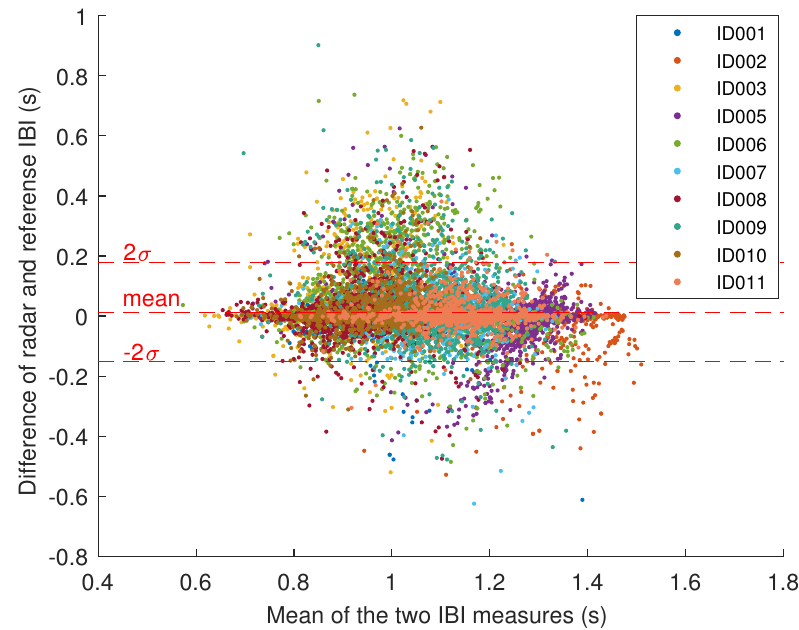
Figure 7. The Bland-Altman plot for interbeat interval. The dashed lines indicate the mean and the interval containing 95% of the